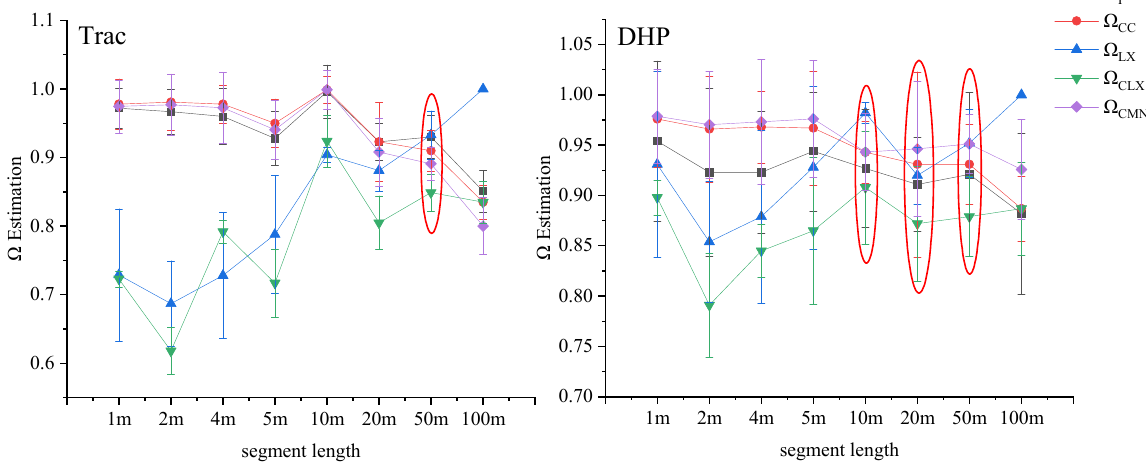
Figure 6. A comparison of CI estimation values with various segment lengths using the Ω LX , Ω CC , Ω CLX , Ω P , and Ω CMN methods.